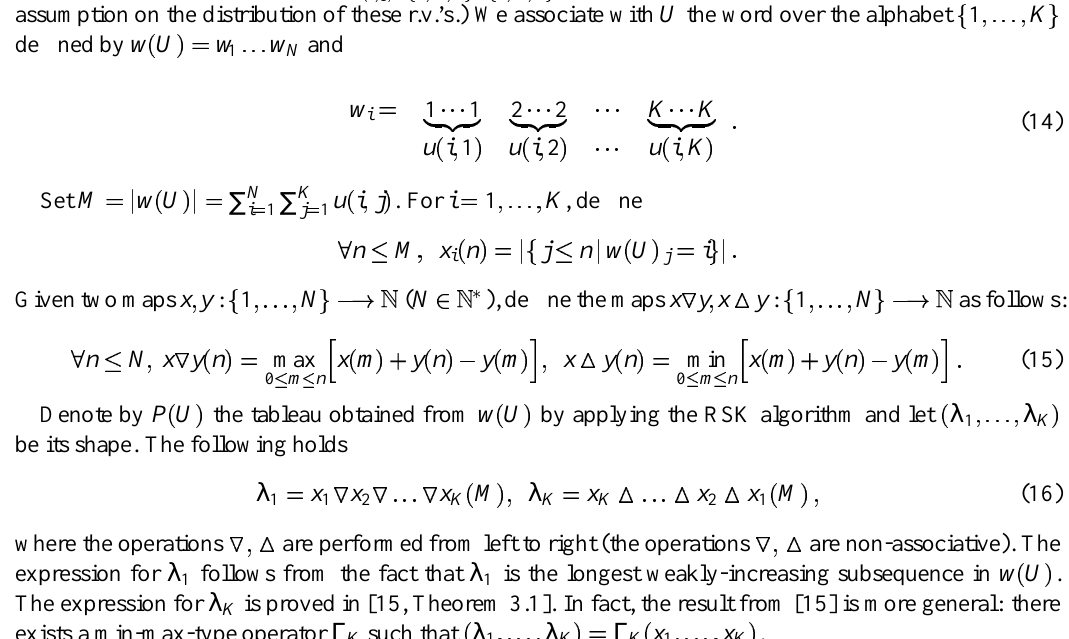
Fig. 4: Ferrers diagram and semi-standard Young tableau of shape